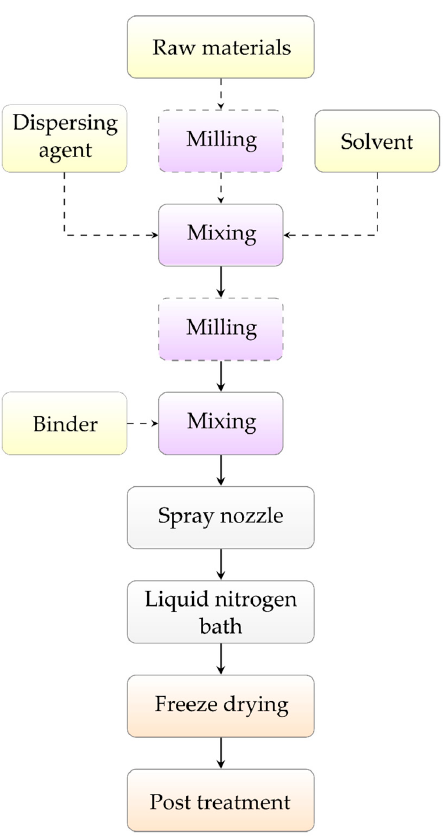
Figure 16. A simple flowchart of the freeze granulation process.